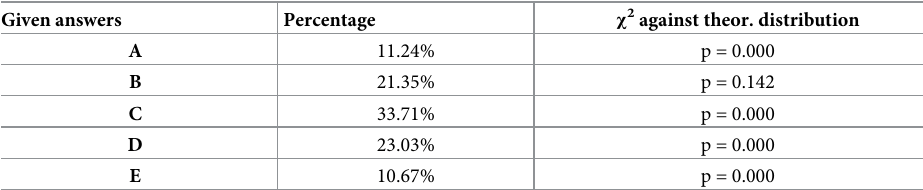
Table 9. Frequency of each answer. Given